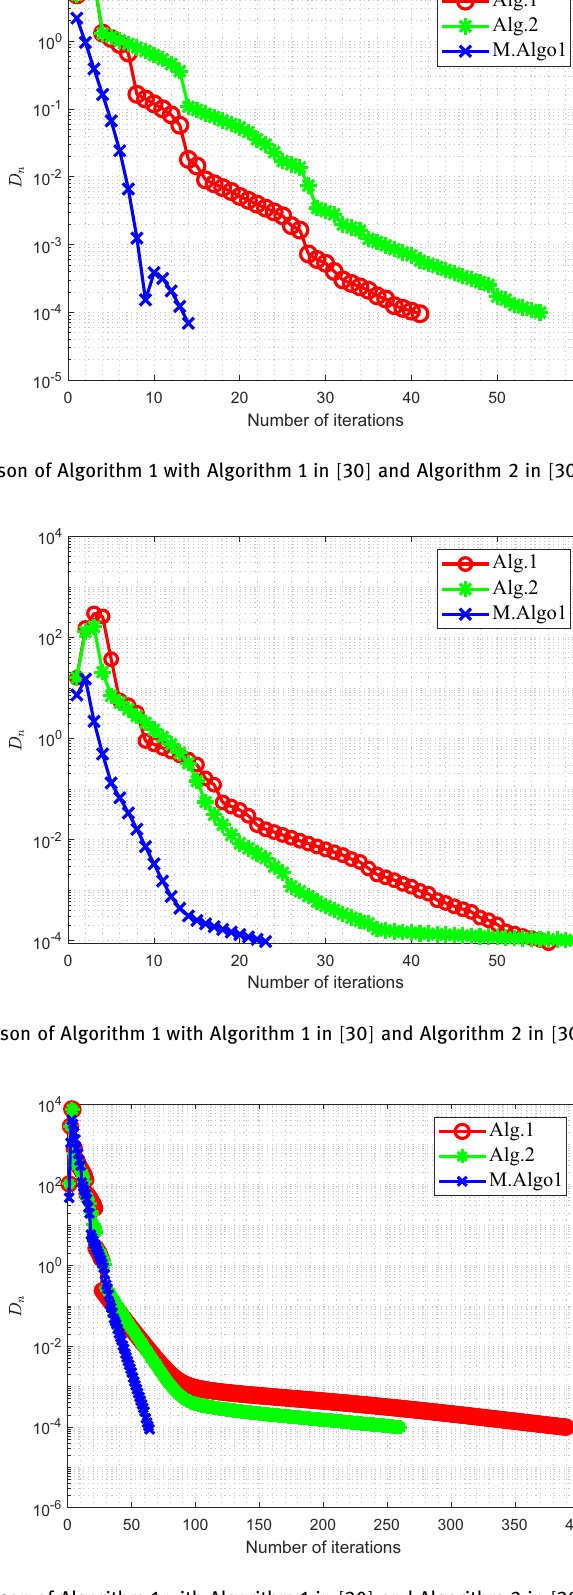
Figure 3: Numerical comparison of Algorithm 1 with Algorithm 1 in [ 30 ] and Algorithm 2 in [ 30 ] taking = N 20 .